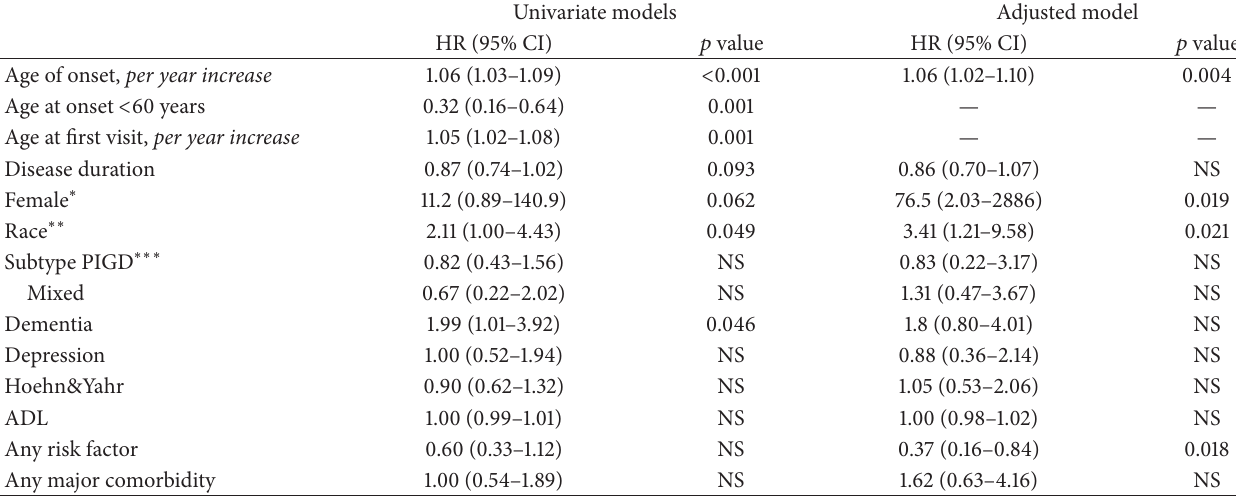
Table 4: Association between baseline characteristics and mortality, expressed as mortality hazard ratio with 95% confidence interval